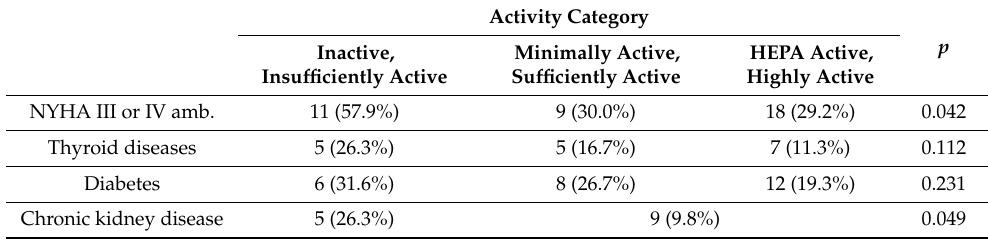
Table 5. Relationship between level of physical activity, NYHA class, and comorbidities.